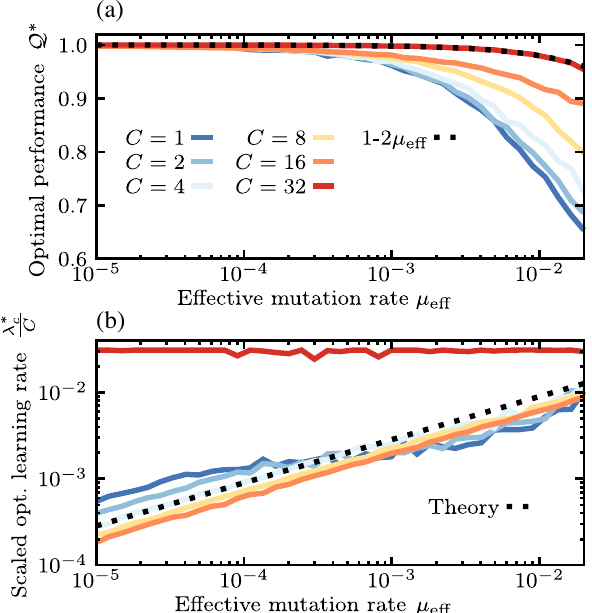
FIG. 3. Compartmentalized memory storage. (a) The optimal performance is shown as a function of the effective mutation rate [similar to Fig. 2(a)] for networks with different number of compartments C (colors) ranging from a network with distributed memory C ¼ 1 (blue) to a 1-to-1 compartmentalized network C ¼ N (red). (b) The optimal (scaled) learning rate λ =C is shown c as a function of the effective mutation rate for networks with different number of compartments [colors according to (a)]. Full lines show the numerical estimates, and the dashed line is from ffiffiffiffiffiffiffiffiffiffiffiffiffiffiffiffiffiffiffiffiffiffiffiffiffi p 8 μ − 1 = ð N the analytical approximation λ (cid:4) Þ ≈ C λ (cid:4) 1 . The c ¼ c c scaled learning rates collapse on the analytical approximation for all networks except for the 1-to-1 compartmentalized network (red), where the maximal learning rate λ ≈ 1 is used, and each compartment is fully updated upon an encounter with a new version of a pattern. The number of presented patterns is set to N ¼ 32 . We keep L × C ¼ const, with L ¼ 800 used for the network with C ¼ 1